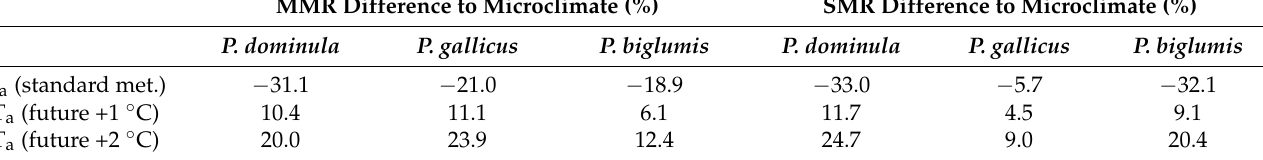
Table 3. Deviation of energetic costs of paper wasps during a breading season between differ- ent climate scenarios, calculated as difference between microclimate measurements and standard meteorological temperature data 2018–2020 (T a (standard met.)) and future climate scenarios with a temperature increase of 1 ◦ C or 2 ◦ C above ambient temperature at the nest (T a (future)). T a (standard met.) temperature deviation from microclimate ambient nest temperature was − 3.6 ◦ C in P. dominula , − 2.4 ◦ C in P. gallicus , and − 3.3 ◦ C in P. biglumis ). MMR = mixed activity metabolic rate, SMR = standard metabolic